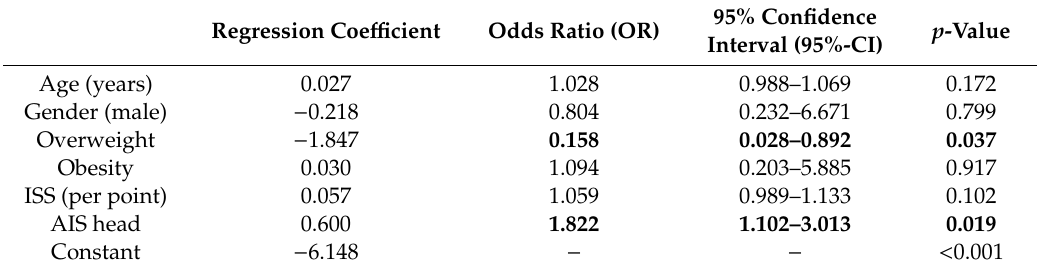
Table 2. Multivariate regression analysis of patients with Abbreviated Injury Scale (AIS) chest ≥ 3 referring to mortality.